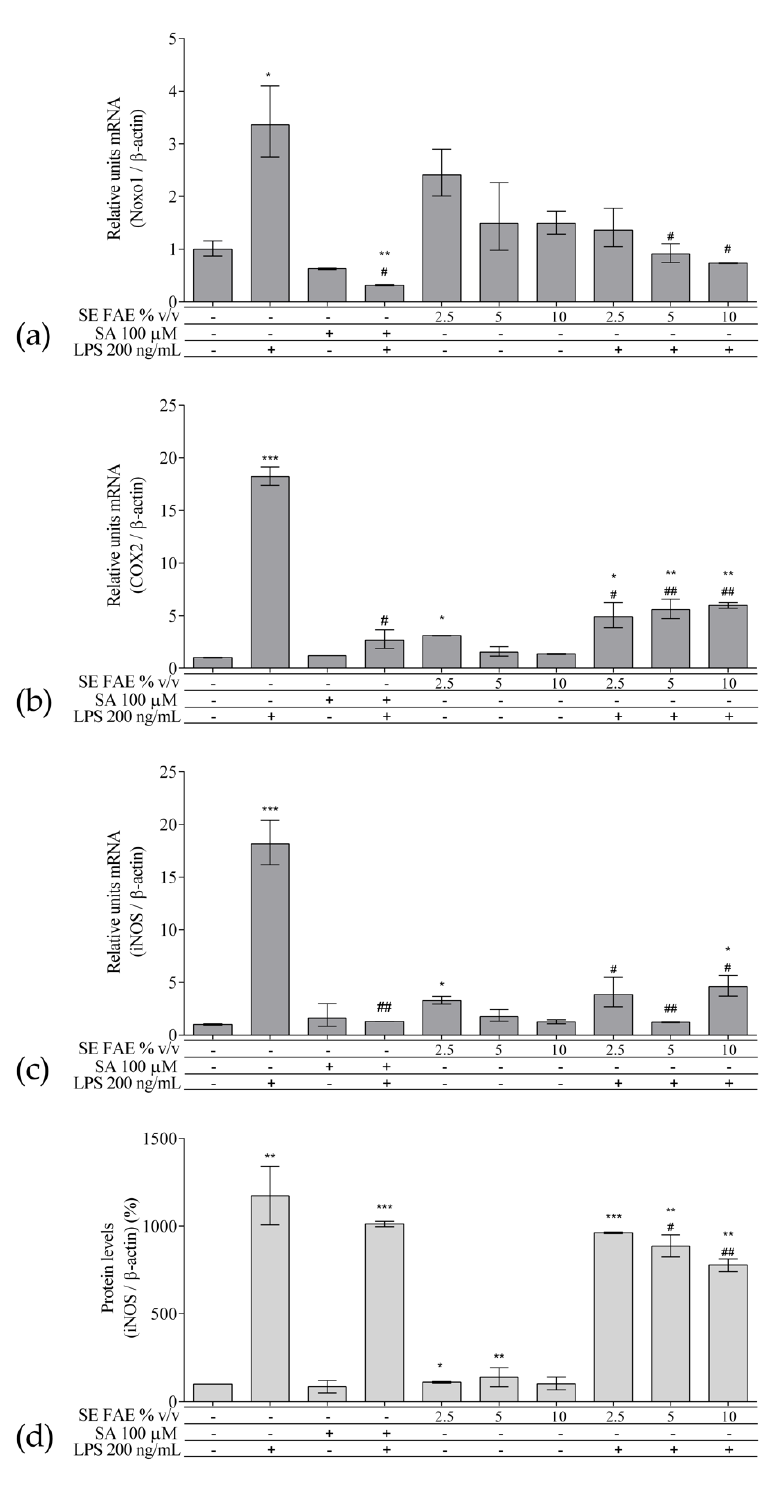
Figure 3. Changes in mRNA levels of COX2 ( a ), iNOS ( b ), Noxo1 ( c ), and of protein levels of iNOS ( d ) in J774A.1 mouse macrophages pre-treated with increasing concentrations (2.5%, 5%, 10% v / v ) of SE FAE or with SA for 24 h and subsequently stimulated or not with LPS. Results were obtained using qPCR (( a ), ( b ) and ( c )) or western blot technique ( d ). Data are presented as mean ± SEM. Legend: SE FAE– Sambucus ebulus L. fruit aqueous extract; SA–100 µ M salicylic acid; LPS–200 ng/mL lipopolysaccharides. * p < 0.05, ** p < 0.01, *** p < 0.001 vs. untreated cells; # p < 0.05, ## p < 0.01 vs. LPS treatment.